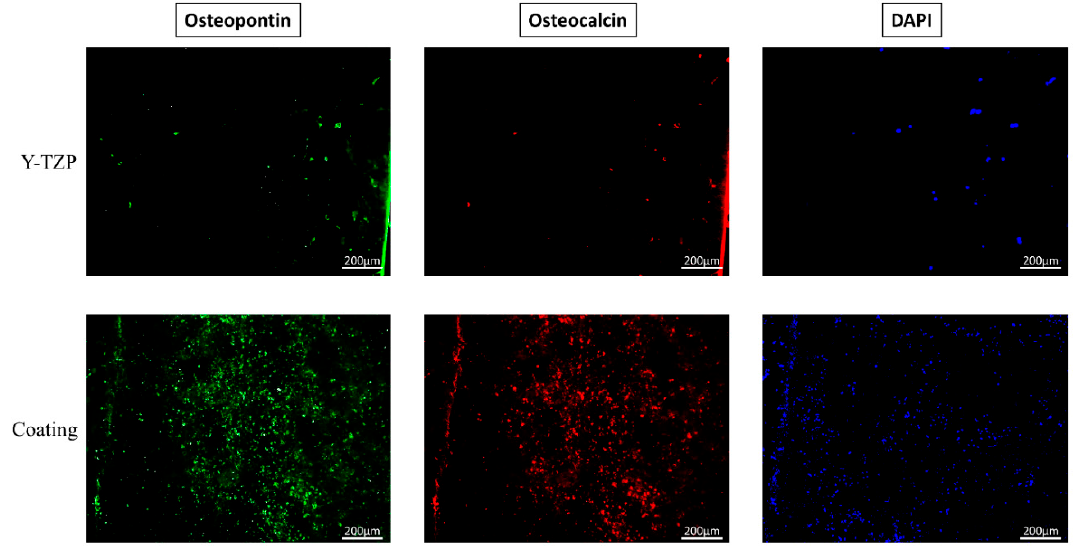
Figure 10. Y-TZP fluorescence micrograph samples after exposure to SaOS-2 cells. Green and red stains identify osteocalcin and osteopontin, respectively, while blue shows cell nuclei.